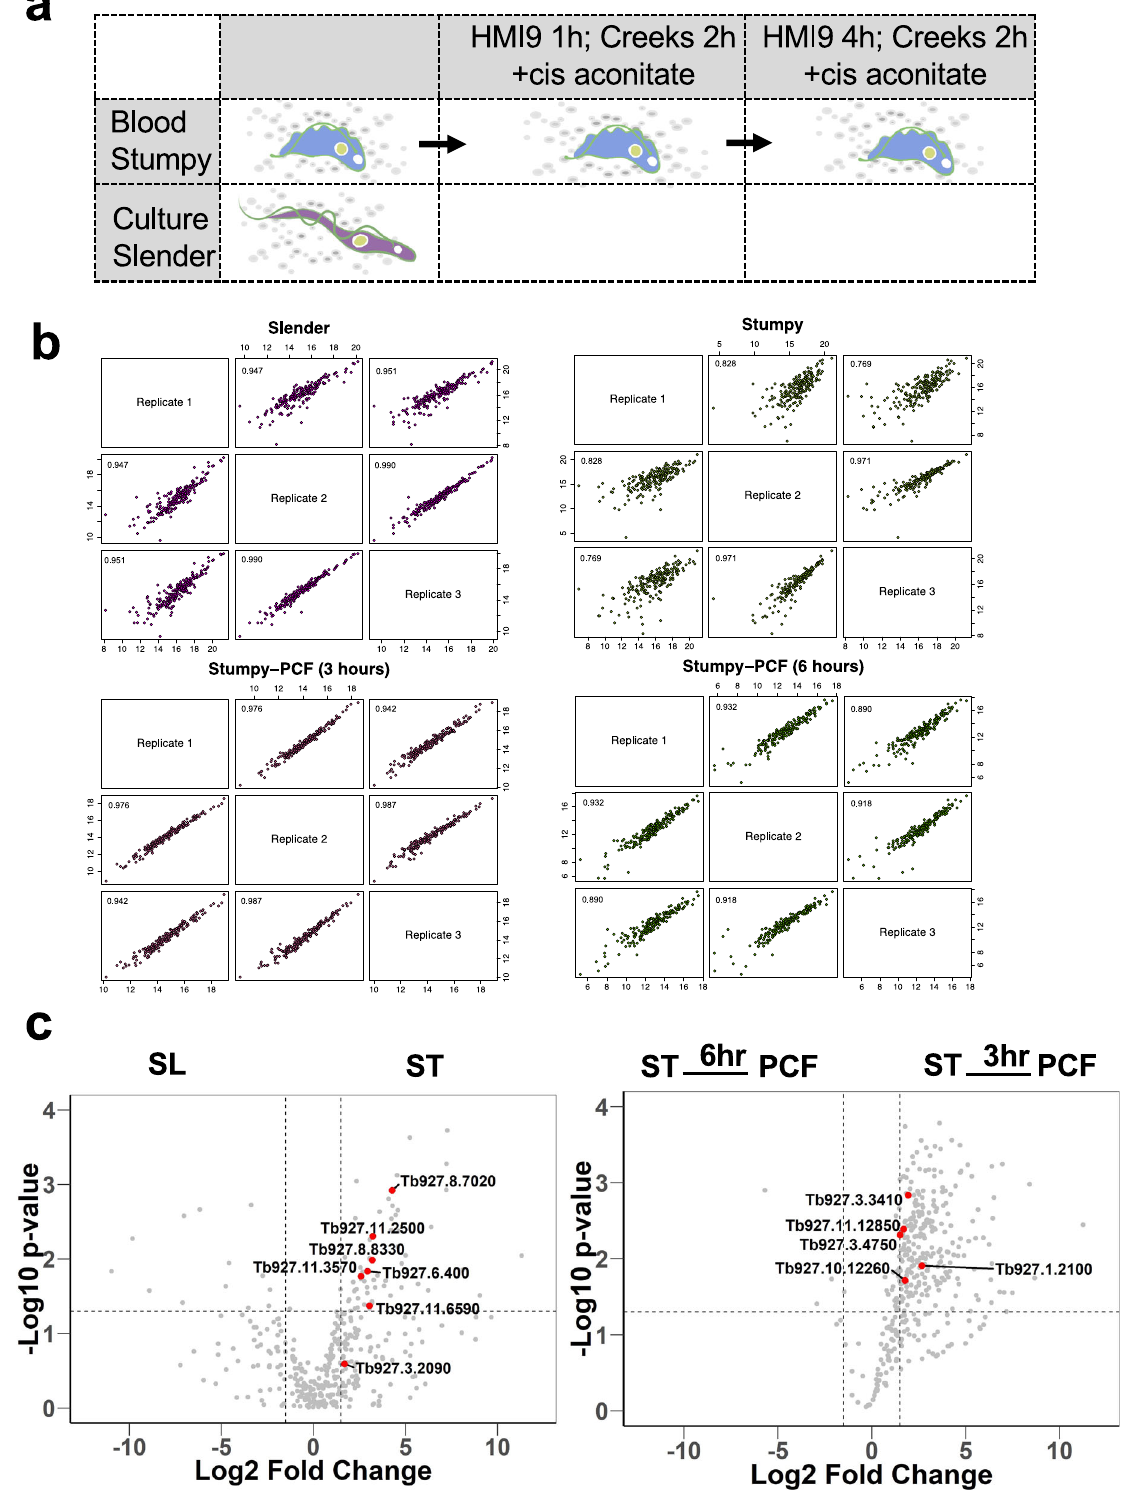
Fig. 1 Mass spectrometry analysis of released trypanosome proteins. a Schematic representation of the samples used for the analysis of the secreted proteome from bloodstream slender forms, stumpy forms or stumpy form parasites undergoing differentiation to procyclic forms. b Scatter plots showing the reproducibility of three biological replicates of secreted material released from slender forms, stumpy forms or cells 3 h or 6h into differentiation to procyclic forms. c Volcano plots of proteins detected as released from either slender or stumpy forms (left-hand panel) or during early differentiation (right-hand panel) highlighting released peptidases. Log2 of the fold change (FC) is plotted on the x -axis and the − log10 of the p value (ANOVA) on the y -axis. The vertical dotted lines indicate a fold change >1.5 and the horizontal dotted line a p value<0.05. Red dots represent peptidases detected in the dataset; signi fi cance thresholds are indicated by dotted lines. SL is slender, ST is stumpy and PCF is procyclic. Source data are provided as a source data fi le.